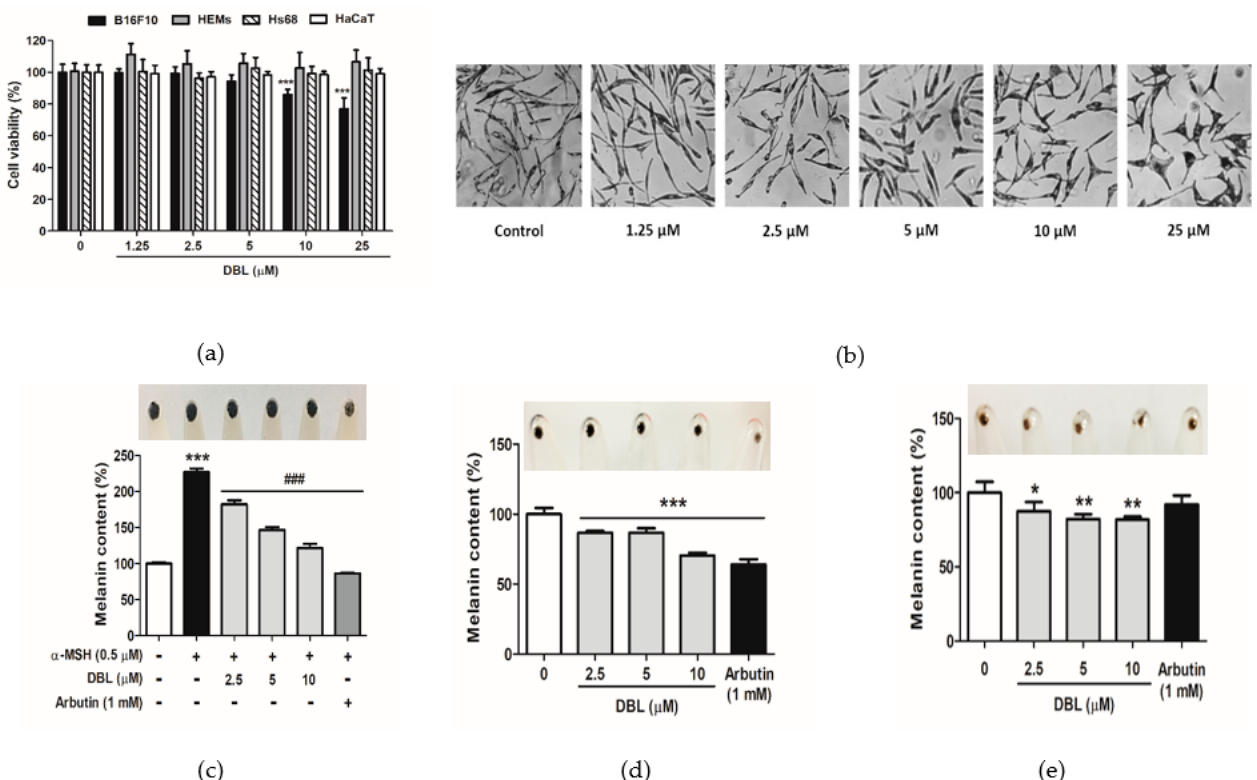
Figure 2. Cell viability, dendritic morphology, and melanin content of DBL. ( a ) The cell viability (%) of B16F10 at 48 h, human epidermal melanocytes (HEMs) at 72 h, and Hs68 and HaCaT cells at 24 h. ( b ) Representative dendritic morphology of DBL in HEMs at 72 h. ( c ) Melanin content (%) of B16F10 and cell pellets stimulated with α -melanocyte-stimulating hormone ( α -MSH) and DBL for 48 h. ( d ) Melanin content (%) of B16F10 and cell pellets treated with DBL for 48 h. ( e ) Melanin content (%) of HEM cells and cell pellets treated with DBL for 72 h. All data have been presented as mean ± SD. Significant difference versus control group: * p < 0.05, ** p < 0.01, *** p < 0.001. Significant difference versus α -MSH-treated group: ### p < 0.001. Positive control: 1 mM arbutin.